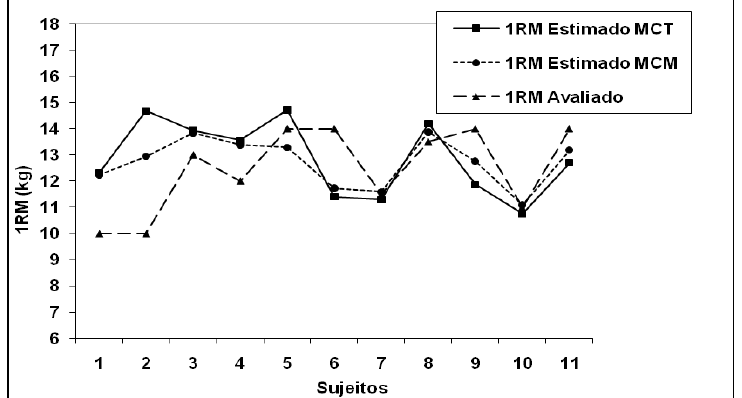
Figura 3. Diferença entre o 1RM avaliado ( ) e o 1RM predito por coeficientes gerados pela MCT